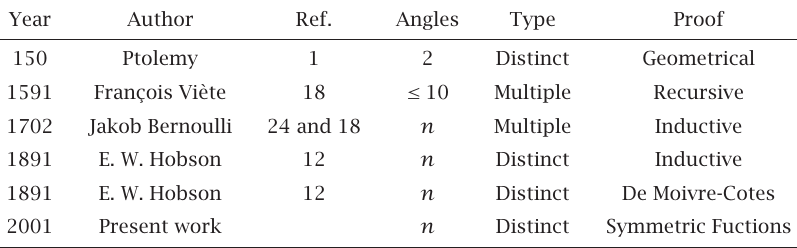
Table 2.1 . Proofs of the polygonometric